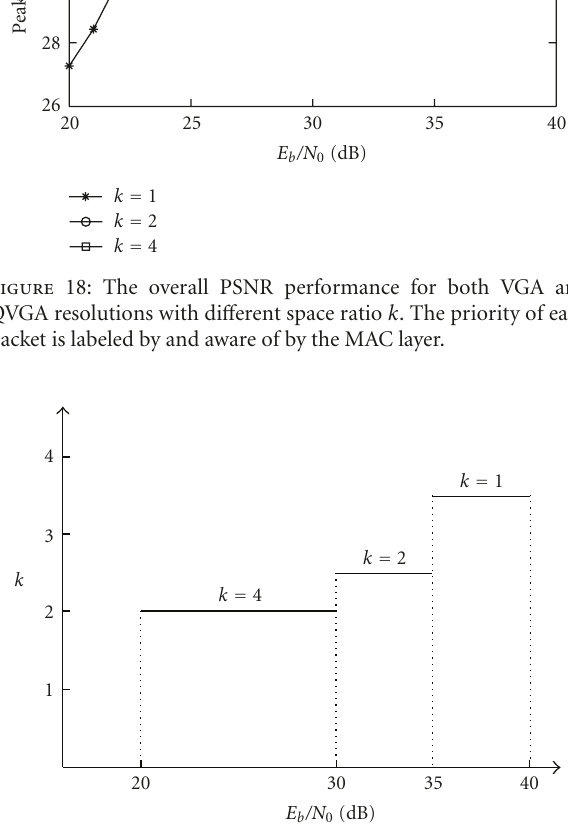
Figure 19: A hierarchical constellation scheme for the best overall PSNR performance using a selection of k